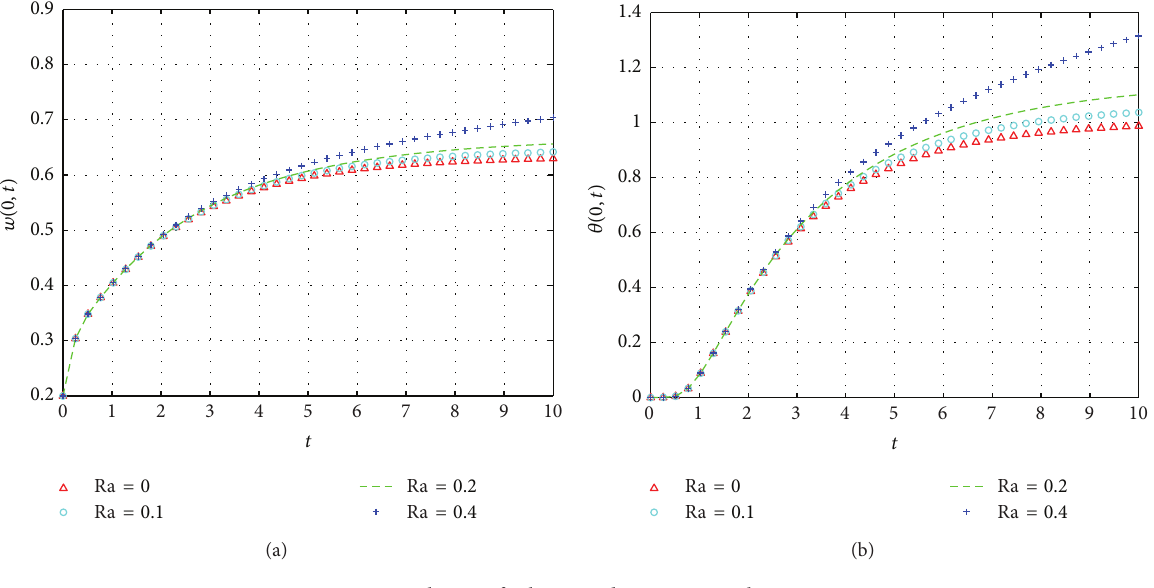
Figure 6: Evolution of velocity and temperature along 𝑦 = 0